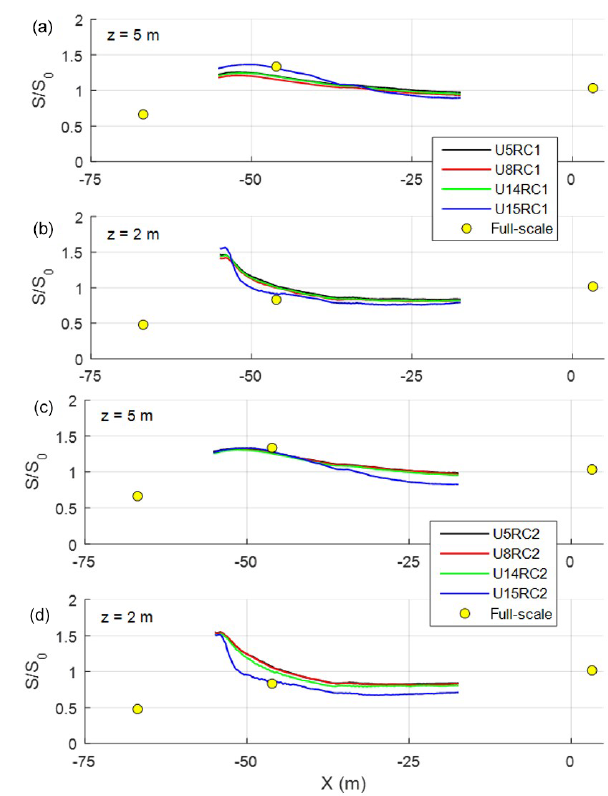
Figure 11. Horizontal profiles of speed-up ratio for (a) RC1 cases, z = 5m, (b) RC1 cases, z = 2m, (c) RC2 cases, z = 5m, and (d) RC2 cases, z = 2m.